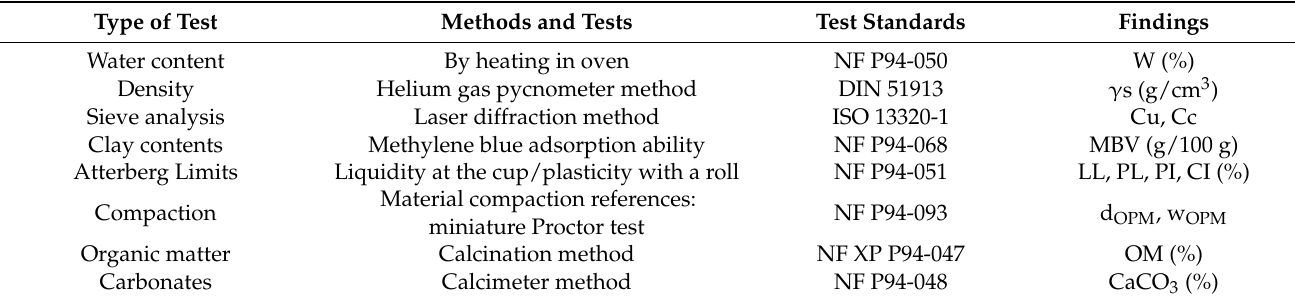
Table 5 . Geotechnical characterization of each trench cuttings.